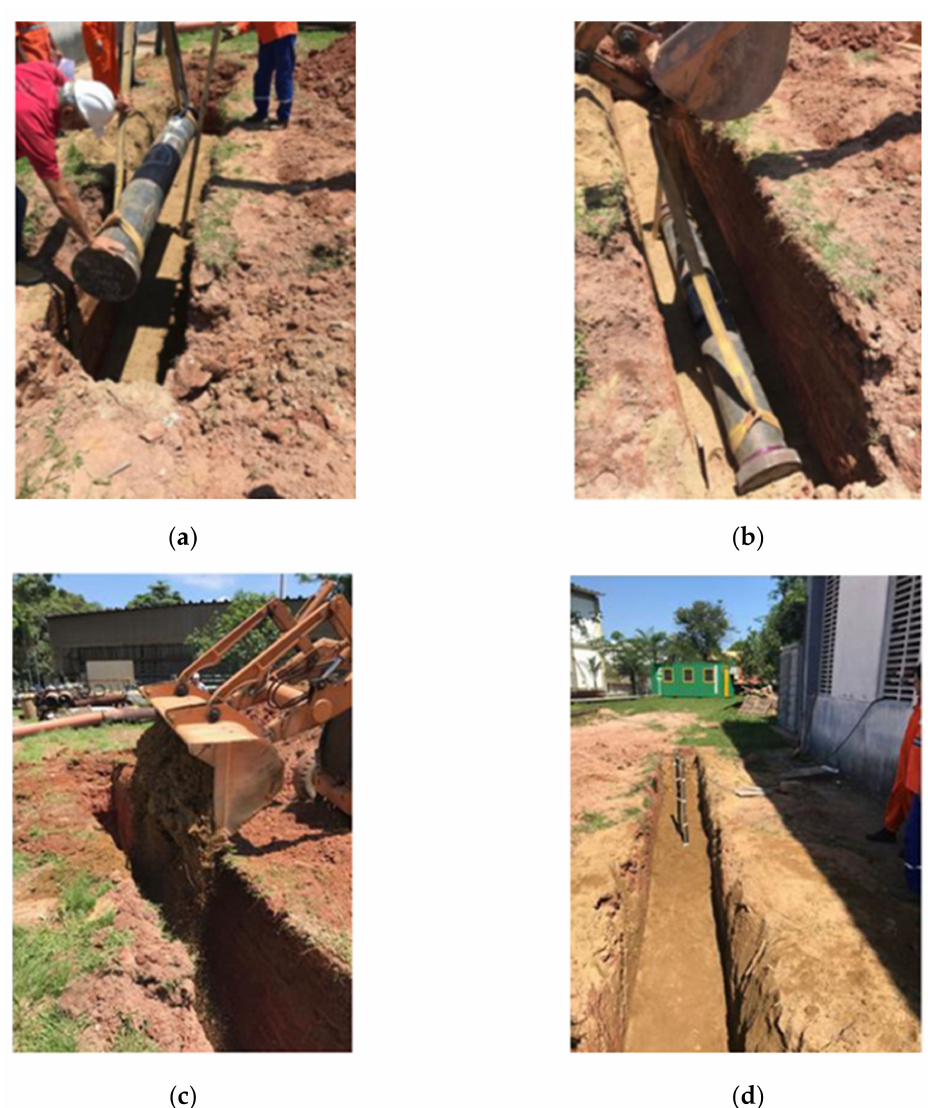
Figure 4. Stages of burying the specimens in the ground: ( a ) digging the ditch, ( b ) positioning the specimens in the ditch, ( c ) covering them with the selected material, ( d ) specimen buried in the